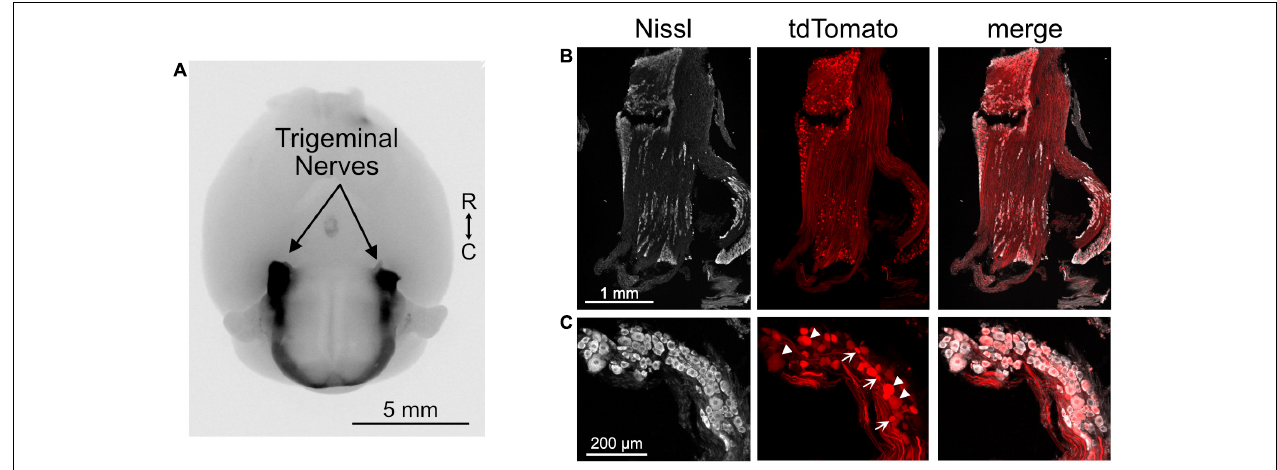
FIGURE 3 | Trigeminal ganglion labeled with AAV.PHP-s virus. (A) Image of ventral aspect of the brain of a mouse that received a retro-orbital injection of AAV.PHP-s.CAG.tdTomato. The trigeminal nerves are brightly labeled, as are axons in the spinal cord that likely originate from dorsal root ganglia. tdTomato is shown in black. R, rostral; C, caudal. (B) Section of trigeminal ganglion demonstrating that many somata were labeled by this approach. (C) Neurons with a diverse range of soma sizes were labeled. Arrowheads – large somata and arrows – small somata.